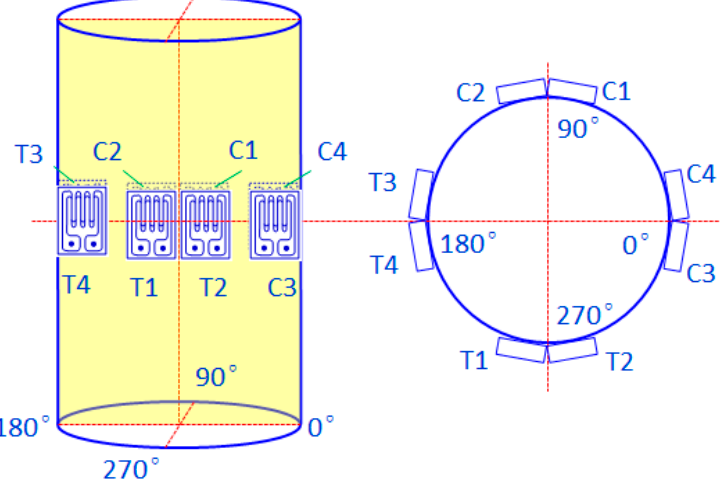
Figure 2. Strain gauge distribution of lateral force.